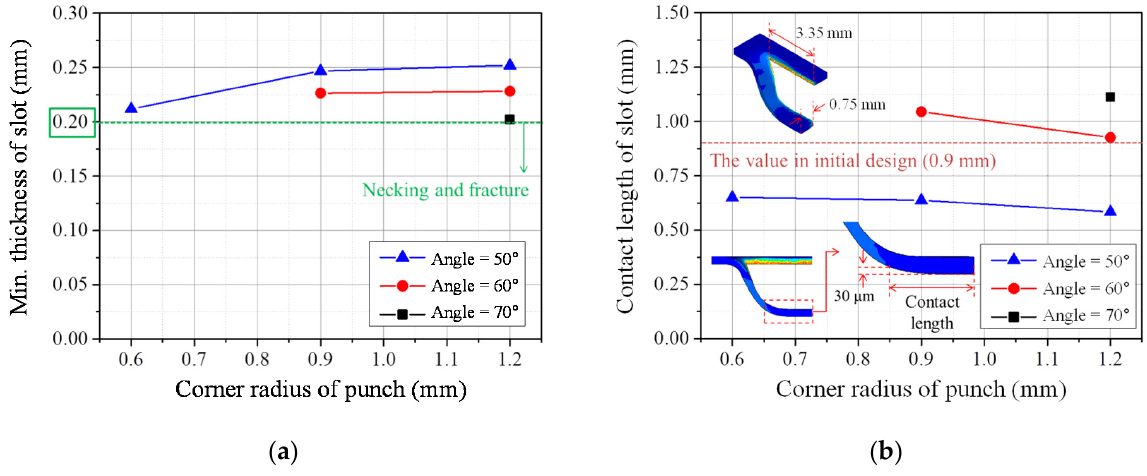
Figure 10. Effect of slope angle and corner radius of punch on ( a ) minimum thickness and ( b ) contact length of the slot in one-stage forming.